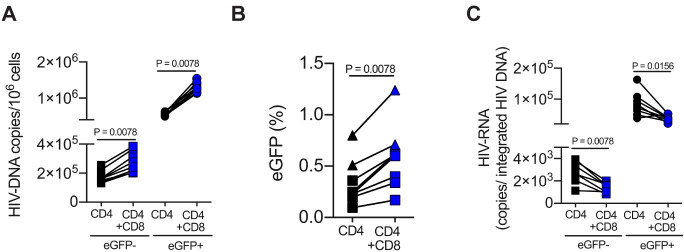
Infected CD4+ T cells co-cultured with CD8+ T cells accumulate reservoir-harboring cells compared to CD4+ T cells alone.All in vitro infections were conducted using the replication competent NL4-3_eGFP under single cycle condition with protease inhibitor (Darunavir), with the exception of 2 donors who were infected with the (Env)-defective NL4-3_eGFP in the inducible provirus experiment (indicated by triangle symbol). CD4+ T cells from mono- and co-cultures with CD8+ T cells at 1:1 E:T ratio were FACS-sorted based on eGFP+ and eGFP- expression 3 days post-infection (see S3 Fig). Data from 8 subjects are shown. (A) Integrated HIV-DNA copies/106 cells are shown for sorted non-productively infected and uninfected (eGFP-) and sorted-productively infected (eGFP+) CD4+ T cells from mono—or co-cultures. (B) Sorted eGFP-CD4+ T from mono—and co-cultures were reactivated by CD3/28 stimulation three days post-infection and controlled for i) de novo infection with protease inhibitor (Darunavir) and ii) pre-integration events with integrase inhibitor (Dolutegravir). Inducible provirus was determined by the frequency of eGFP+ cells 24 hours post-reactivation using flow cytometry. (C) Levels of HIV transcripts on a per-integrated-provirus basis were calculated by dividing the copy numbers of cell-associated multiply-spliced Tat-Rev HIV-RNA per copy numbers of integrated HIV-DNA per cell. Comparisons between co-cultures and mono-cultures were carried out using Wilcoxon matched-pairs signed rank test.